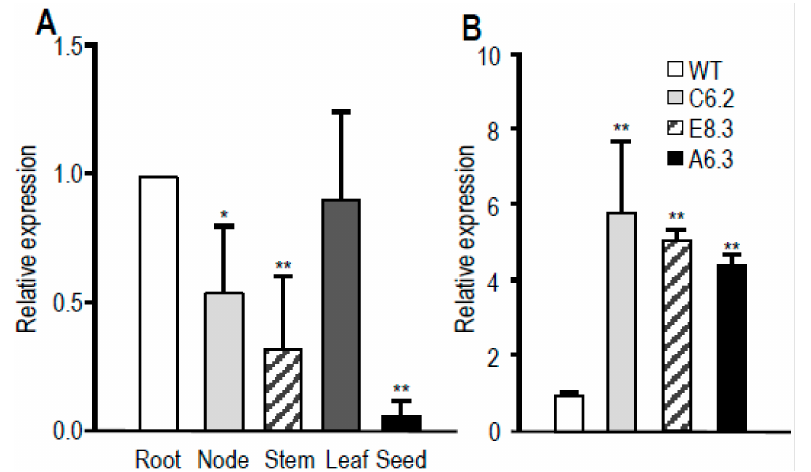
Figure 4. Expression of OsABCG48 in rice normalized to OsActin-1 . ( A ) Field-grown WT rice two weeks after flowering. ( B ) Seven-day-old T2 seedlings from OsABCG48 -transformed lines C6.2, E8.3 and A6.3. Data (bar and error bar) are shown as mean ± SD ( n = 3); statistical analysis by unpaired Student’s t -test compared to WT (* p < 0.05, ** p <